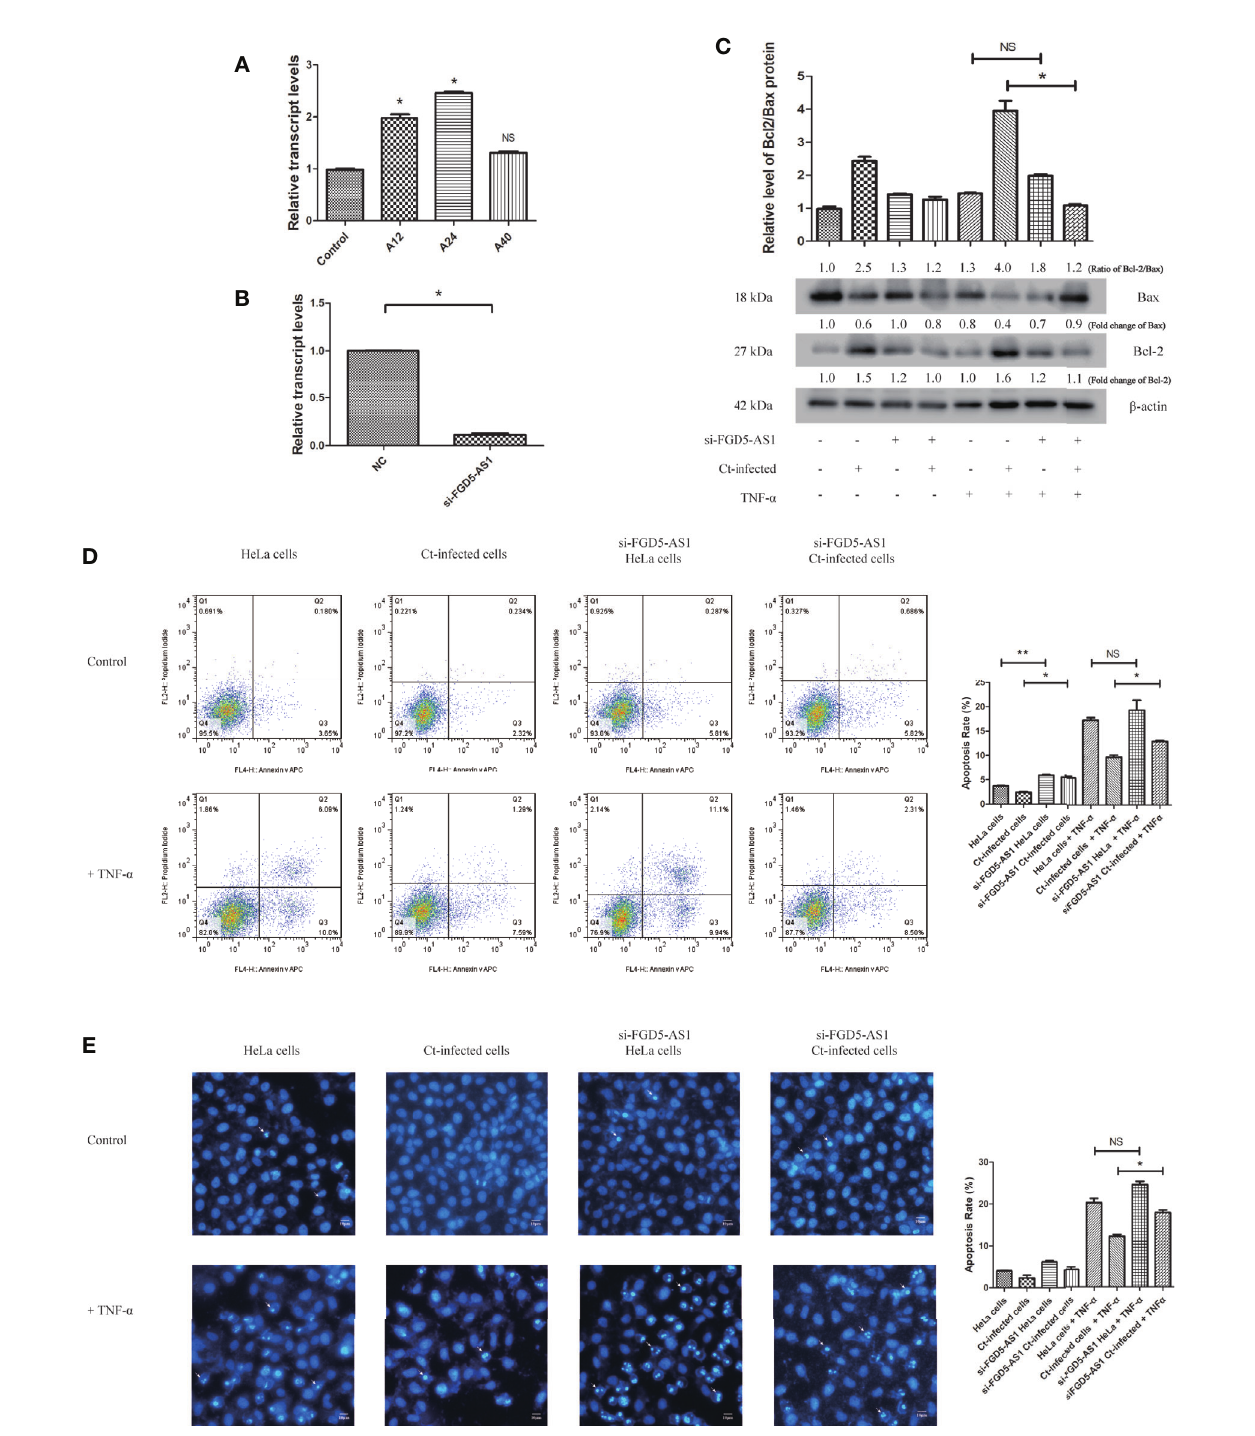
FIGURE 8 | Interference of FGD5-AS1 inhibits the anti-apoptotic effect of Ct-infected cells. (A) RT-qPCR was used to detect the effect of acute infection on expression of FGD5-AS1 at 12 and 24 hpi. The 18S rRNA was used as internal control. (B) RT-qPCR was used to detect the effect of FGD5-AS1 interference by siRNA; 18S rRNA was used as internal control. (C) The expression of Bcl2 and Bax was measured by western blot in HeLa cells and Ct-infected cells after the interference of FGD5-AS1. The upper panel is the ratio of Bcl2/Bax and calculated by the corresponding gray value via Quantity One. (D, E) The apoptotic rate of Ct-infected cells and uninfected cells was detected by FCM (D) and Hoechst staining (E) after interference of FGD5-AS1. The right panel is the apoptosis rate calculated by corresponding experiment. Arrows in (E) denote apoptotic bodies. * P < 0.05; ** P < 0.01; NS, no signi fi